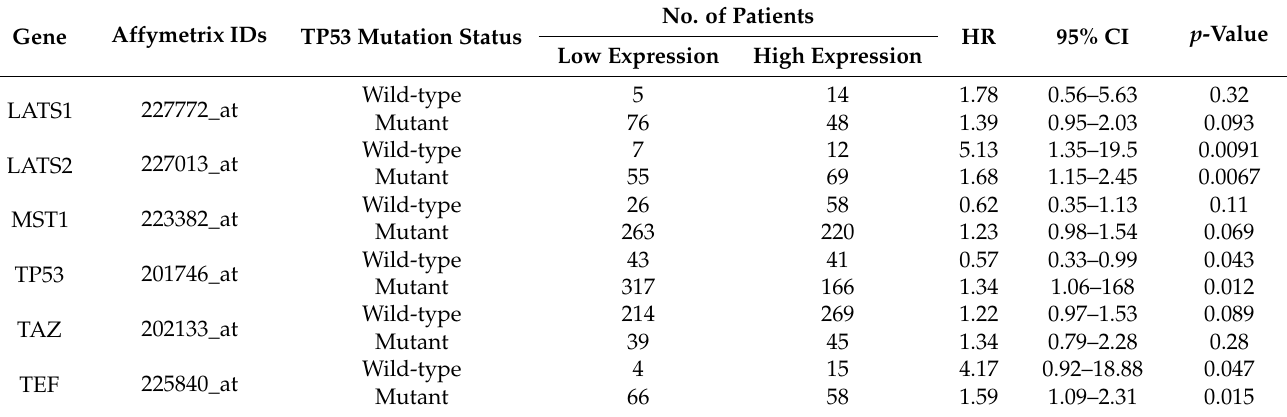
Table 3. Correlation of key Hippo genes with PFS according to TP53 status, hazard ratio, and 95% confidence interval. Gene Affymetrix IDs Gene